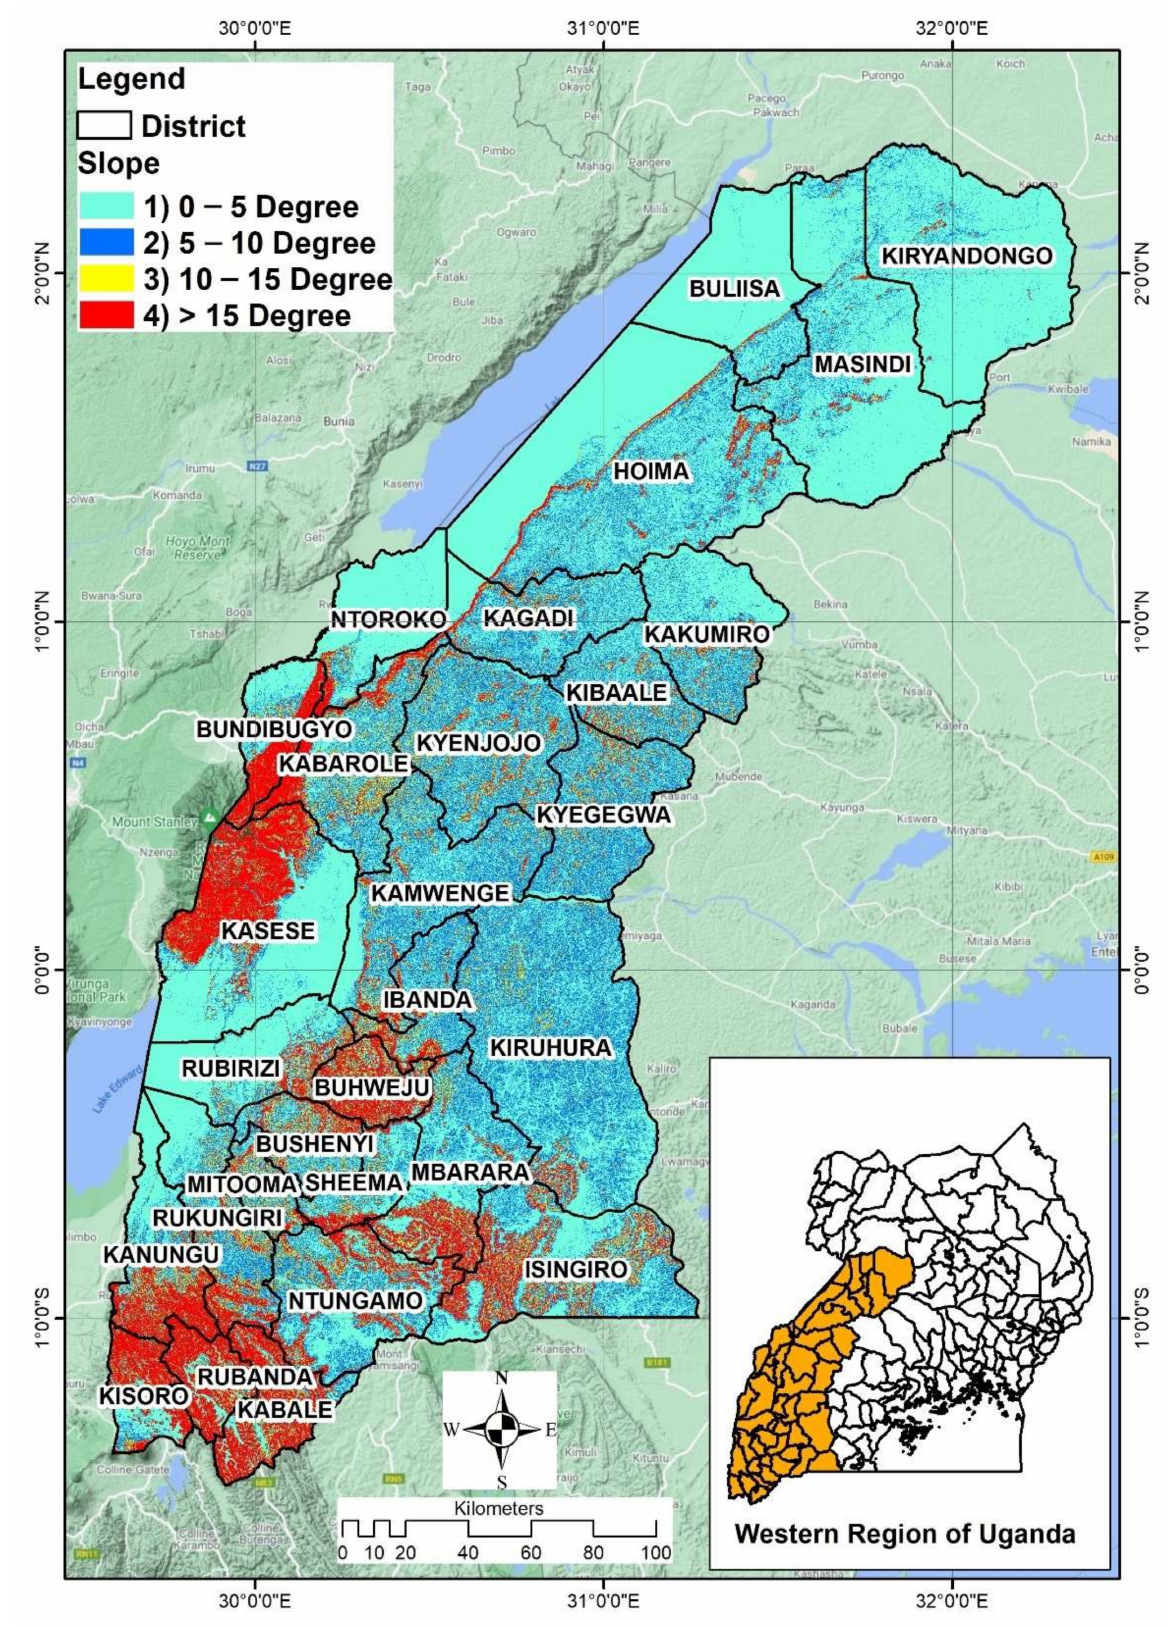
Figure 3. Suitability map of study area by